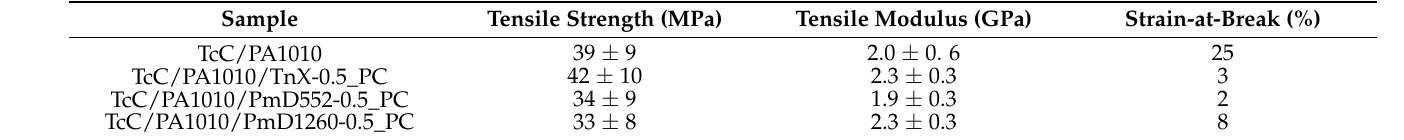
Table 4. Summary of mechanical properties of the TcC/PA1010 filaments extruded with cross-linker chip-coated